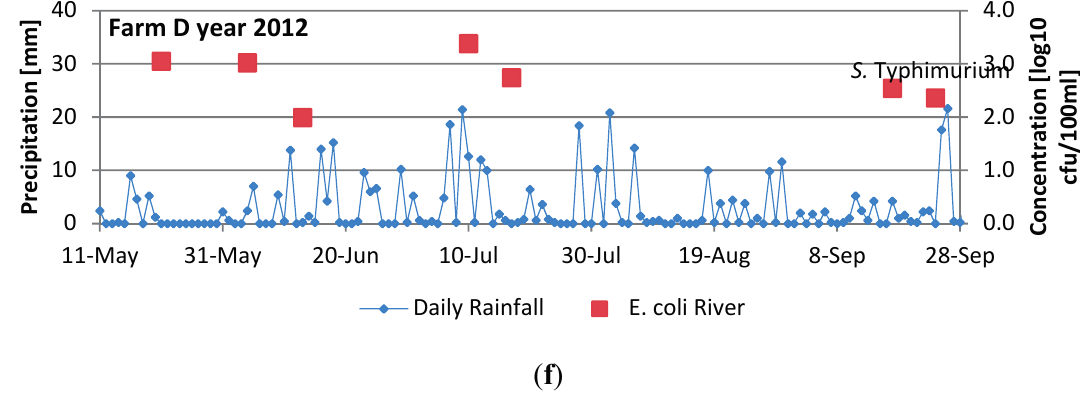
Figure 4. Daily rainfall, concentration of FIOs (log 10 cfu/100 mL) and presence of